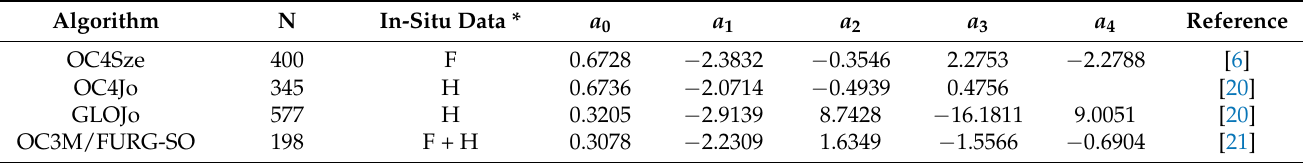
Table 1. Southern Ocean regional algorithms compared in this